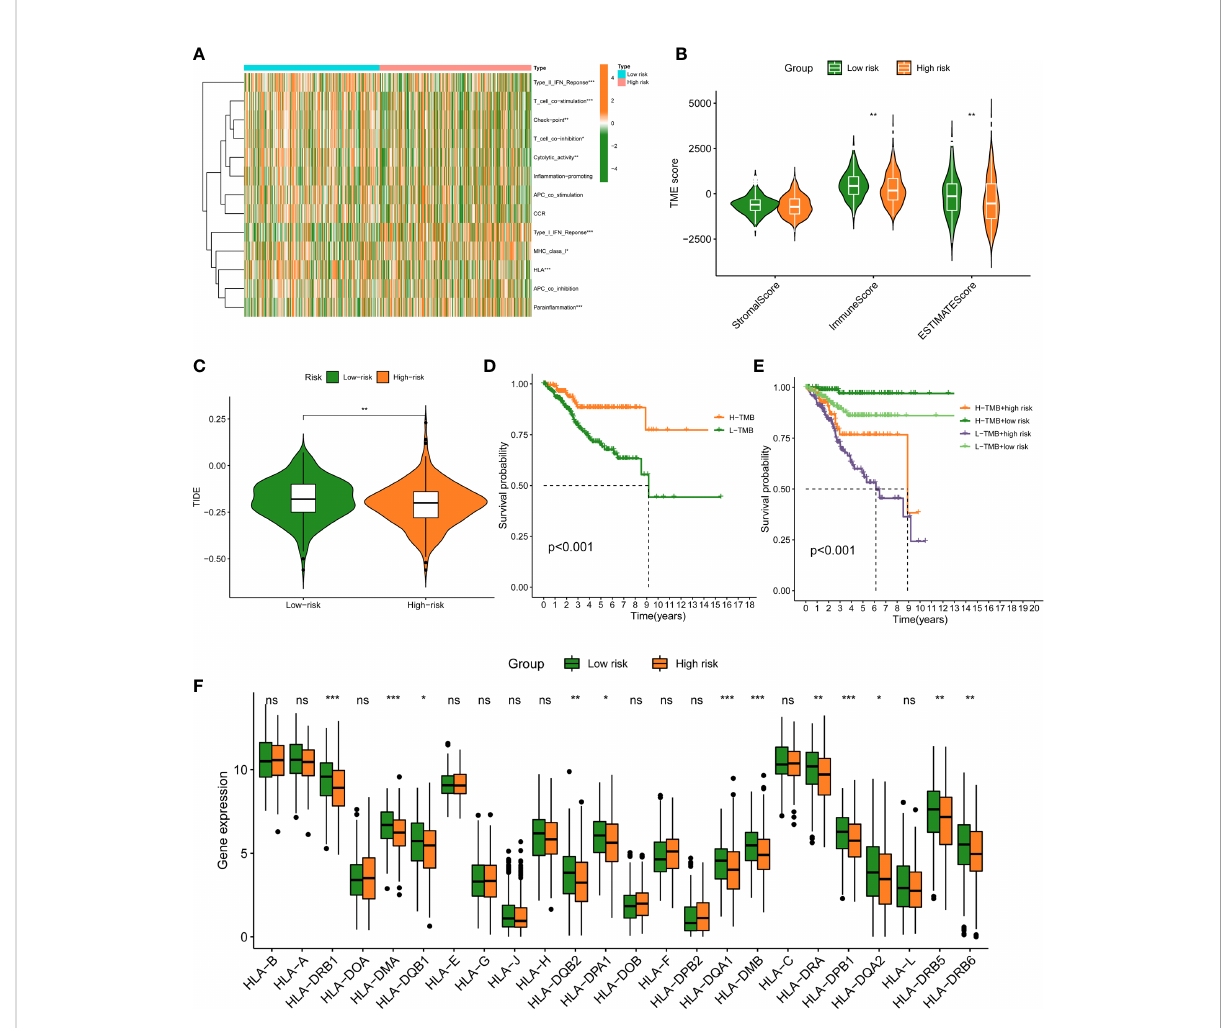
FIGURE 6 Immune landscape between low- and high-FAMGs group. (A) Heat map of immune status between two groups. (B) TME Score in different groups. (C) TIDE score in different groups. (D) K-M analysis of high- and low-TMB group. (E) K-M analysis of four groups classi fi ed by TMB and FAMGs risk score. (F) Box plot of HLA-related gene expressions in two groups. ∗ P <0.05, ∗∗ P <0.01, and ∗∗∗ P <0.001. FAMGs: fatty acid metabolism-related genes. TME: Tumor microenvironment. TIDE: Tumor Immune Dysfunction and Exclusion. K-M: Kaplan-Meier. TMB: tumor mutational burden. ns, not signi fi